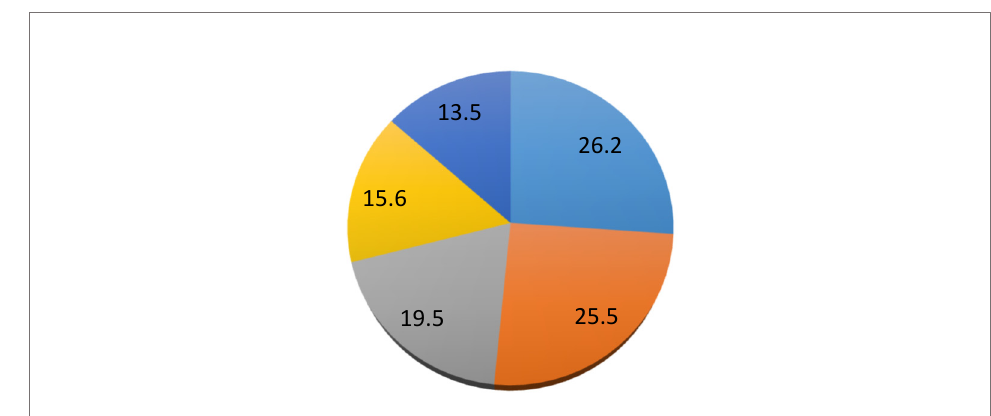
Figure 1. Sources of information about the product (%).